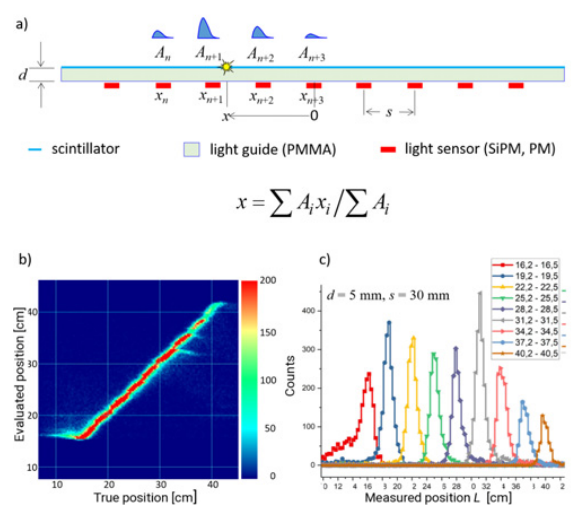
Figure 9. (a) Concept of “proton” detector. (b) Correlation between the evaluated and true hit position measured with a prototype setup as explained in the text. (c) Cross sections of the former distribution along a few selected source